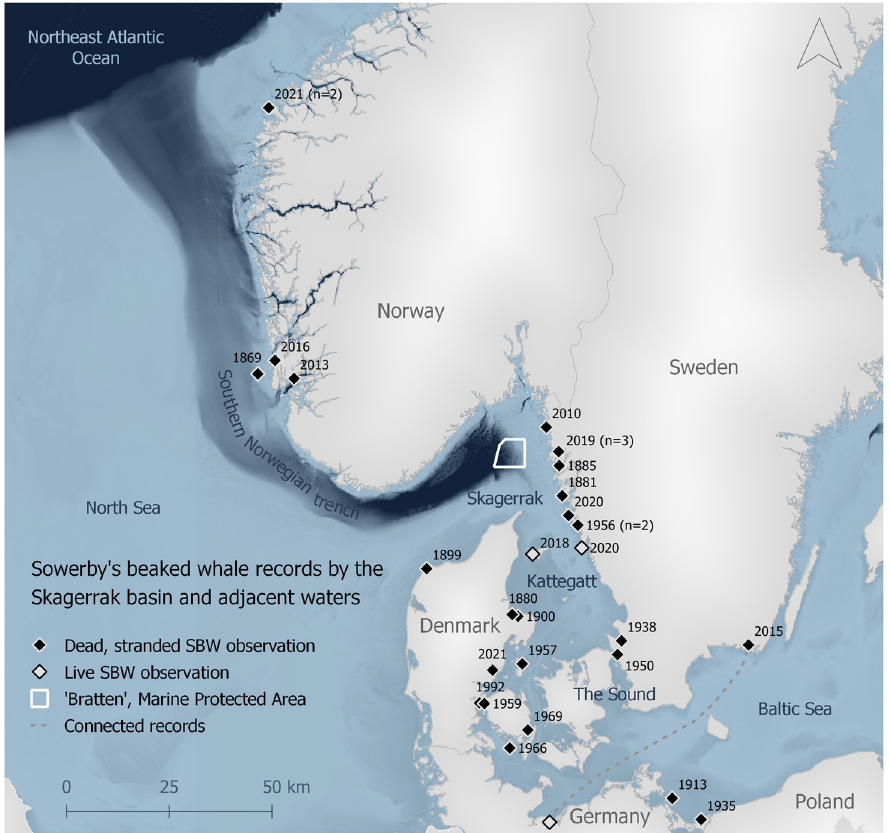
Figure 1. Geographical distribution of observational records of Sowerby’s beaked whales ( Mesoplodon bidens ) in the Skagerrak basin and adjacent waters. GeoData from HELCOM (Open Street Map) [35], EMODnet Digital Bathymetry [36] and Lantmäteriet (MPA) [37].